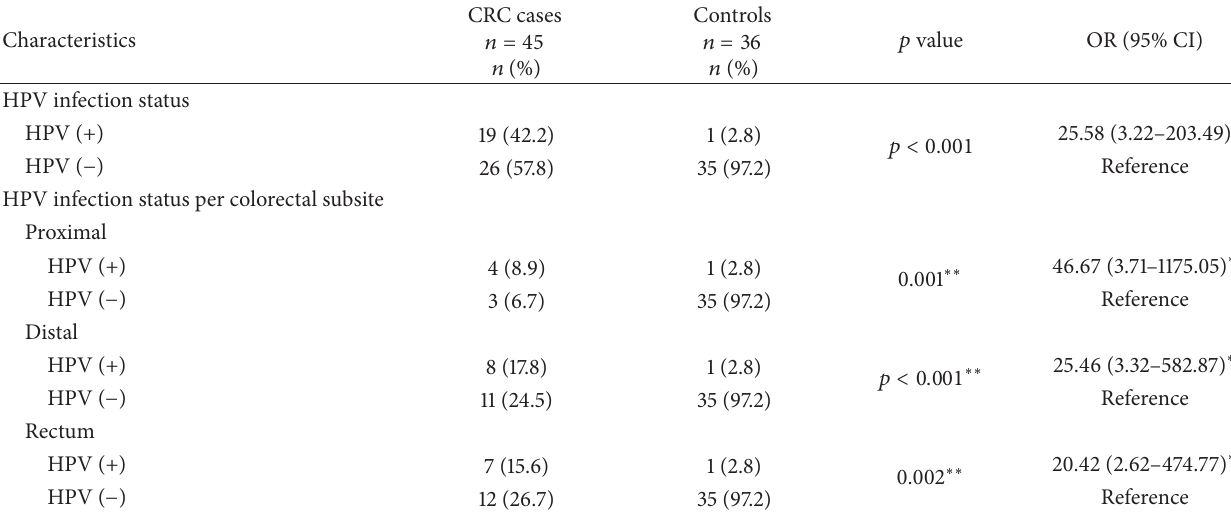
Table 2: Association between HPV infection status and CRC.